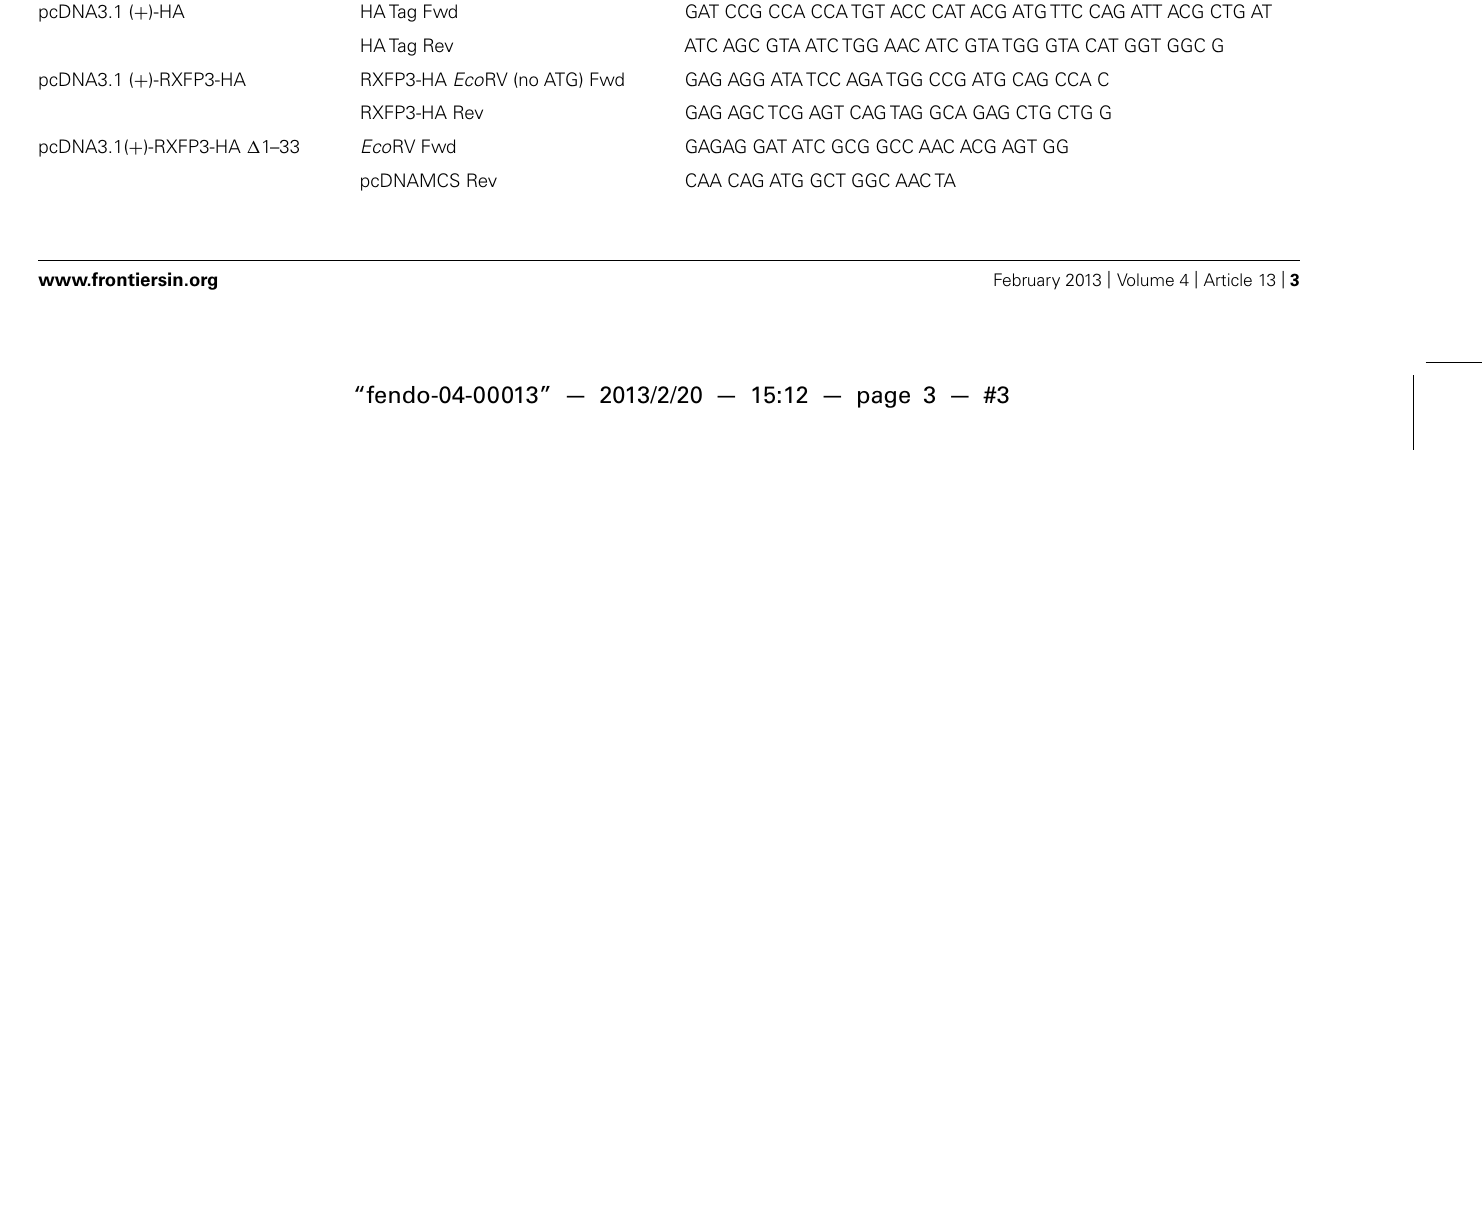
Table 1 | Primers for the production of pcDNA3.1 ( + )-HA, pcDNA3.1 ( + )-HA-RXFP3, and pcDNA3.1 ( + )-HA-RXFP3 Δ 1–33 constructs.